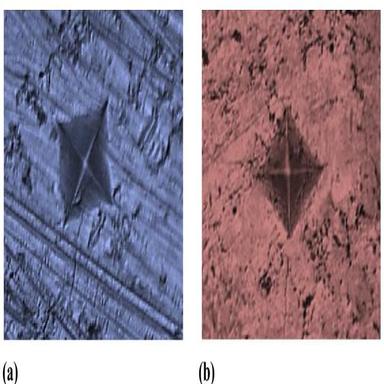
Impression of the Vickers indentation on the (a) unexposed samples and (b) exposed sample (12 kGy) of STS ChGA.